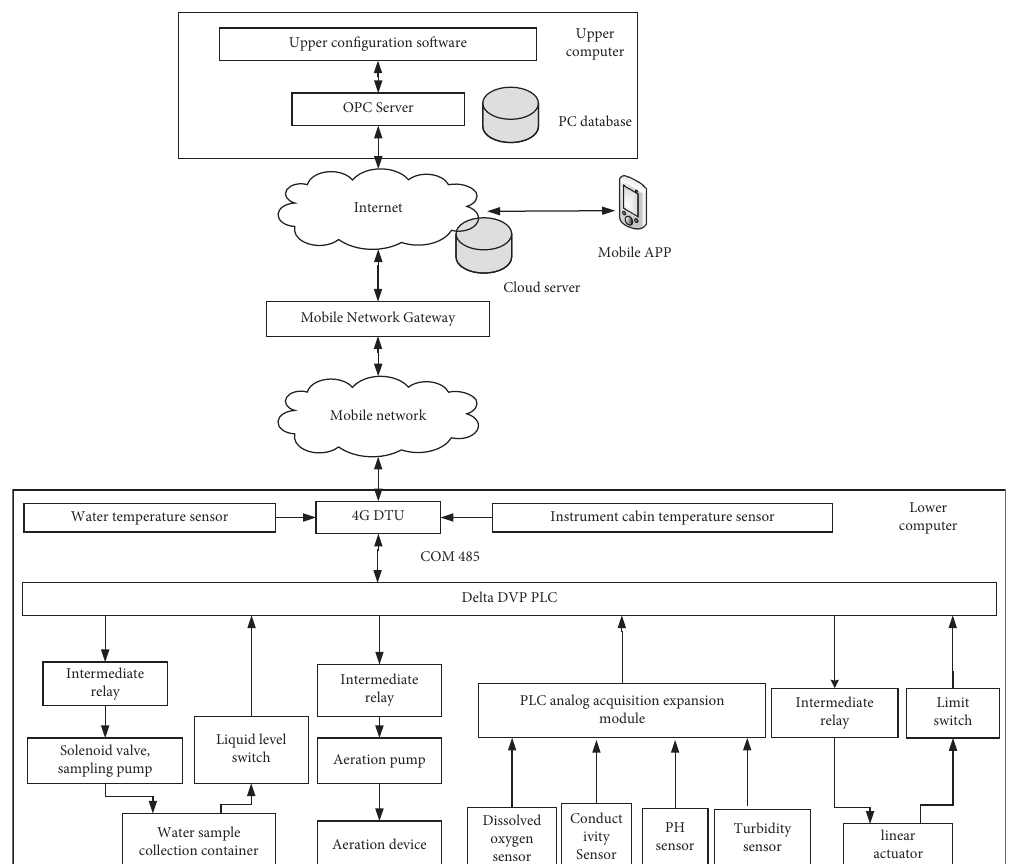
Figure 2: Composition of the sensors monitoring system.